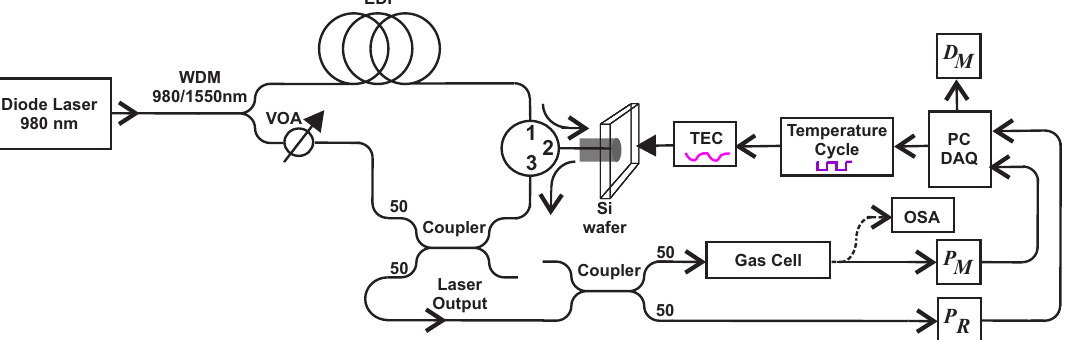
Figure 10. DA-ATLAS dual channel gas sensor setup. WDM, Wavelength Division Multiplexer; VOA, Variable Optical Attenuator; EDF, Erbium-Doped Fiber; TEC, Thermo Electric Cooler; OSA, Optical Spectrum